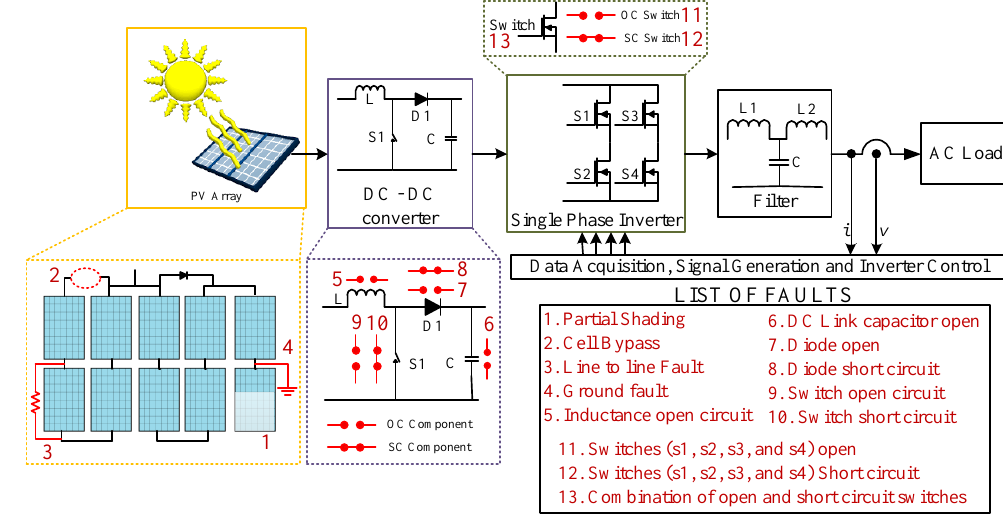
Figure 4. Faults simulated in the single-phase two-stage standalone PV system. Table 2. Faults analyzed in the simulated PV system.